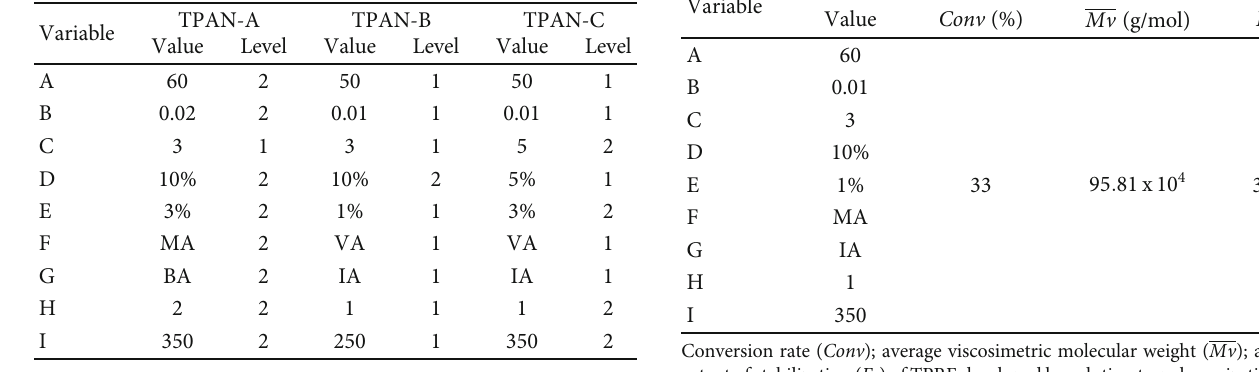
Table 6: Terpolymerization conditions used to improve the conversion rate of terpolymer Conv , average viscosimetric molecular weight ( Mv ), and extent stabilization Es.